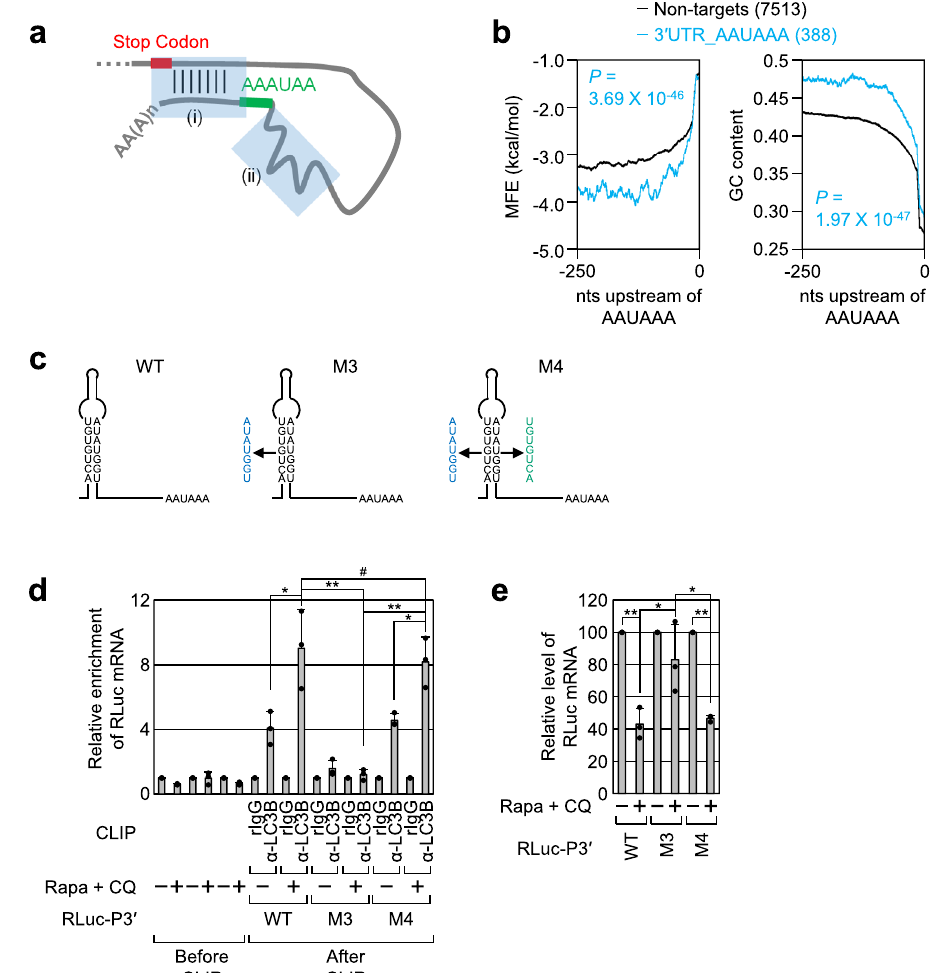
Fig. 4 Presence of secondary or tertiary structures upstream of the AAUAAA motif promotes an association between LC3B and LMD substrates. a Common features found in LMD substrates. Two common features, (i) a long-range looping and (ii) the secondary or tertiary structures upstream of the AAUAAA motif, are indicated by semi-transparent rectangles. b MFE values (left) and GC content (right) across the nucleotide positions upstream of the AAUAAA motif. The 3 ′ UTR sequences of mRNAs belonging to the 3 ′ UTR_AAUAAA or non-targets group were analyzed. p values were calculated using the two-tailed Kolmogorov – Smirnov test. c Predicted secondary structure of the 3 ′ UTR of PRMT1-WT, M3, and M4. d In vivo CLIPs of endogenous LC3B. As performed in Fig. 3c, except that HEK293T cells were expressed with one of RLuc-P3 ′ reporter mRNAs (WT, M3, or M4 mRNA). n = 3; Data are presented as mean values± SD; p values were analyzed using two-tailed and equal-variance Student ’ s t test; # not signi fi cant; * p < 0.05; ** p < 0.01 (The exact p values are provided in Source Data fi le). e Relative amounts of the RLuc-P3 ′ reporter mRNAs upon treatment with Rapa + CQ. n = 3; Data are presented as mean values± SD; p values were analyzed using two-tailed and equal-variance Student ’ s t test; * p < 0.05; ** p < 0.01 (The exact p values are provided in Source Data fi le). Source data are provided as a Source Data fi